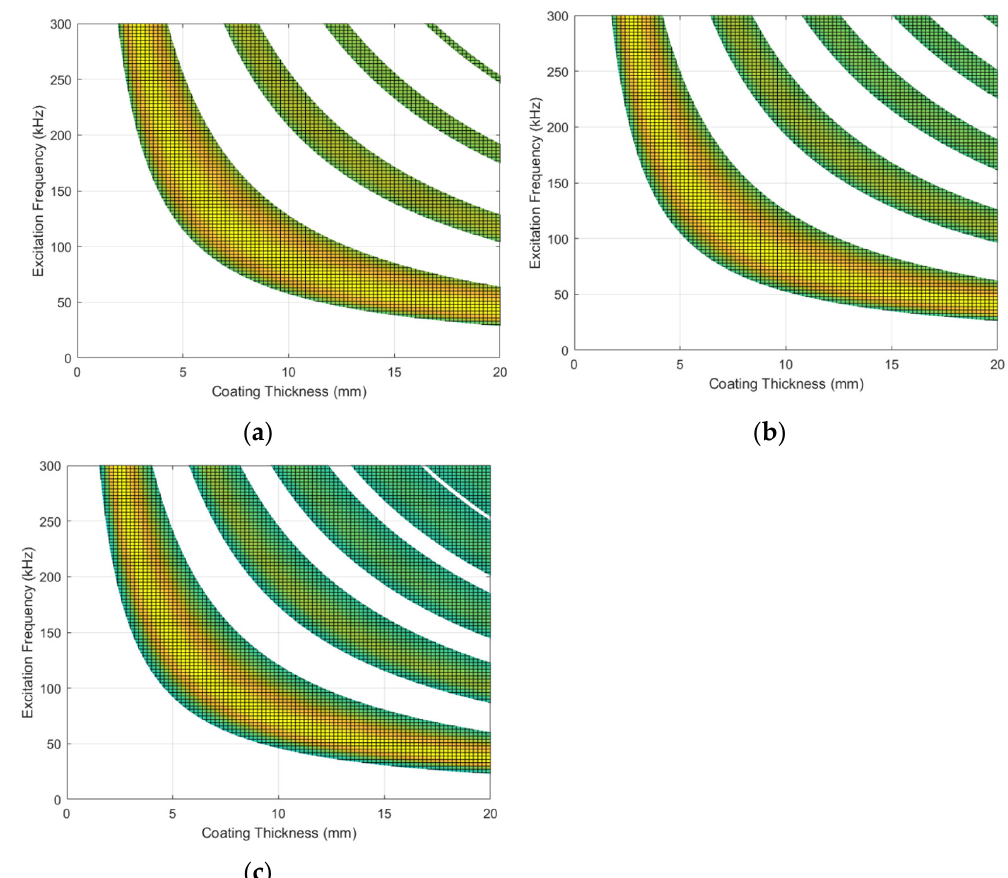
Figure 6. Intervals of interfacial shear delamination in the excitation frequency domain and the coating thickness domain as [ (cid:101) σ − 1 ] = 1.55, the substrate is aluminum and the coating is glaze ice ( a ), rime ice ( b ) and frost ( c ).